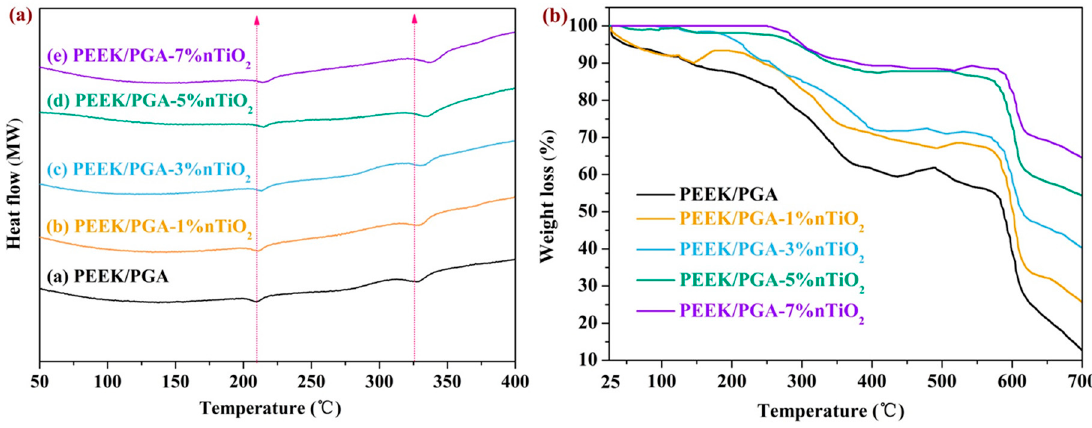
Figure 4. ( a ) Differential scanning calorimetry (DSC) curve and ( b ) thermogravimetric analysis (TGA) curve of the scaffolds with different nTiO 2 contents.